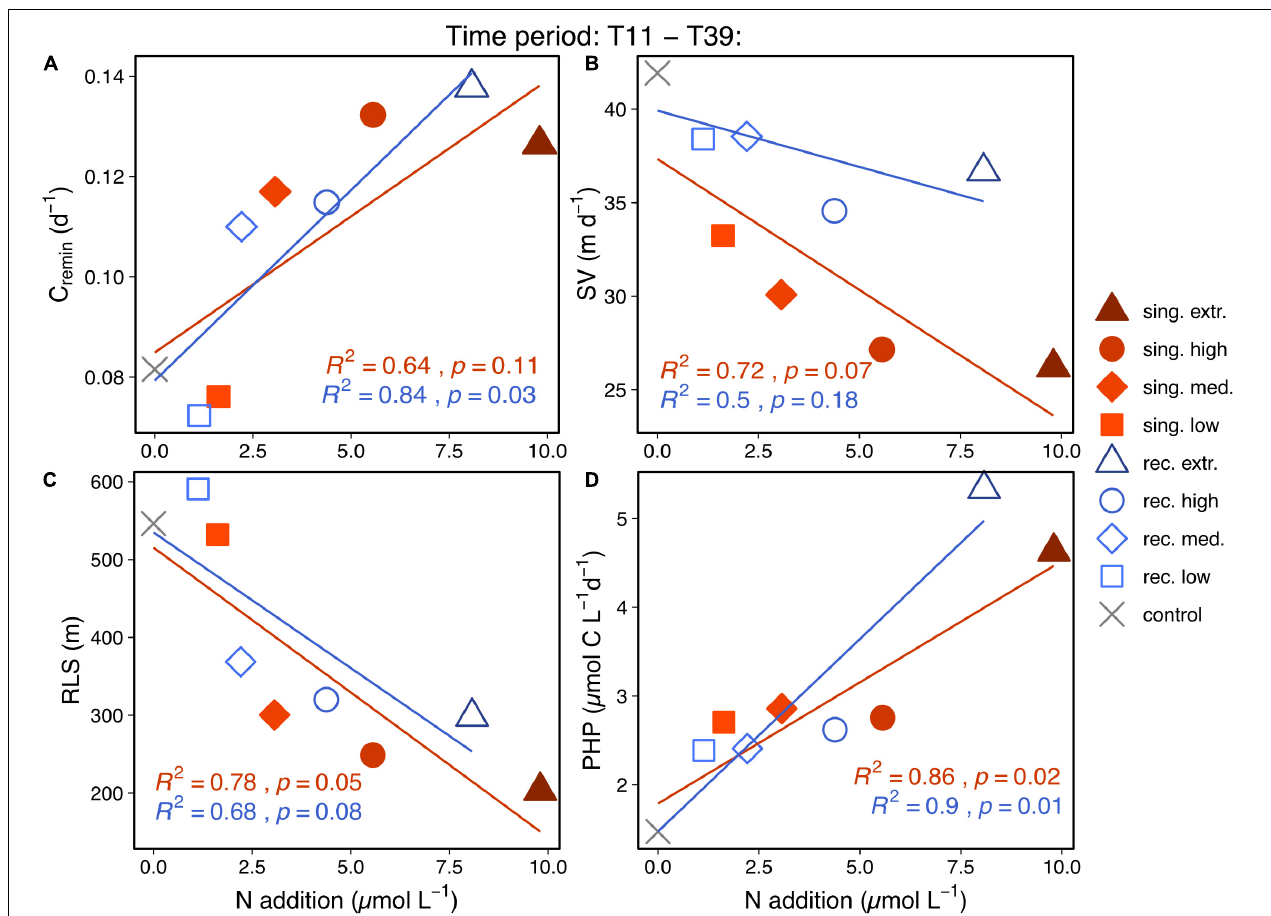
FIGURE 5 | Correlations between mean carbon-specific remineralization rate (A) , mean sinking velocity (B) , mean remineralization length scale (C) and mean prokaryotic heterotrophic production (D) against cumulative N addition. It considers the time frame starting with the singular bloom export event until the end of the experiment (T11–T39), for which means of each of the parameters shown on y-axes were calculated. Since the recurring treatments received multiple deep water additions over time, mean cumulative N additions were calculated for the considered time period. Regression lines are plotted in the color of the corresponding upwelling mode (singular or recurring) and include the control treatment. Regression equations are provided in Supplementary Table 1